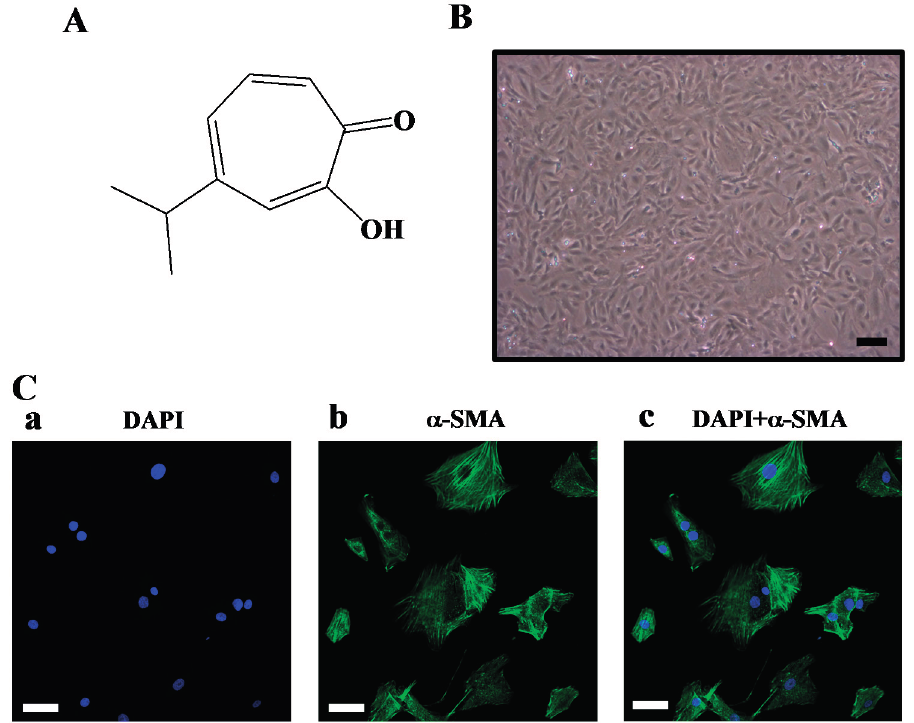
Figure 1. ( A ) The chemical structure of hinokitiol; ( B ) Cell morphology of primary cultured rat vascular smooth muscle cells. The black bar indicates 100 μ m; ( C ) Representative confocal section of immunofluorescence staining for nuclear staining DAPI in blue and α -smooth muscle actin (SMA) in green. The white bar indicates 50 μ